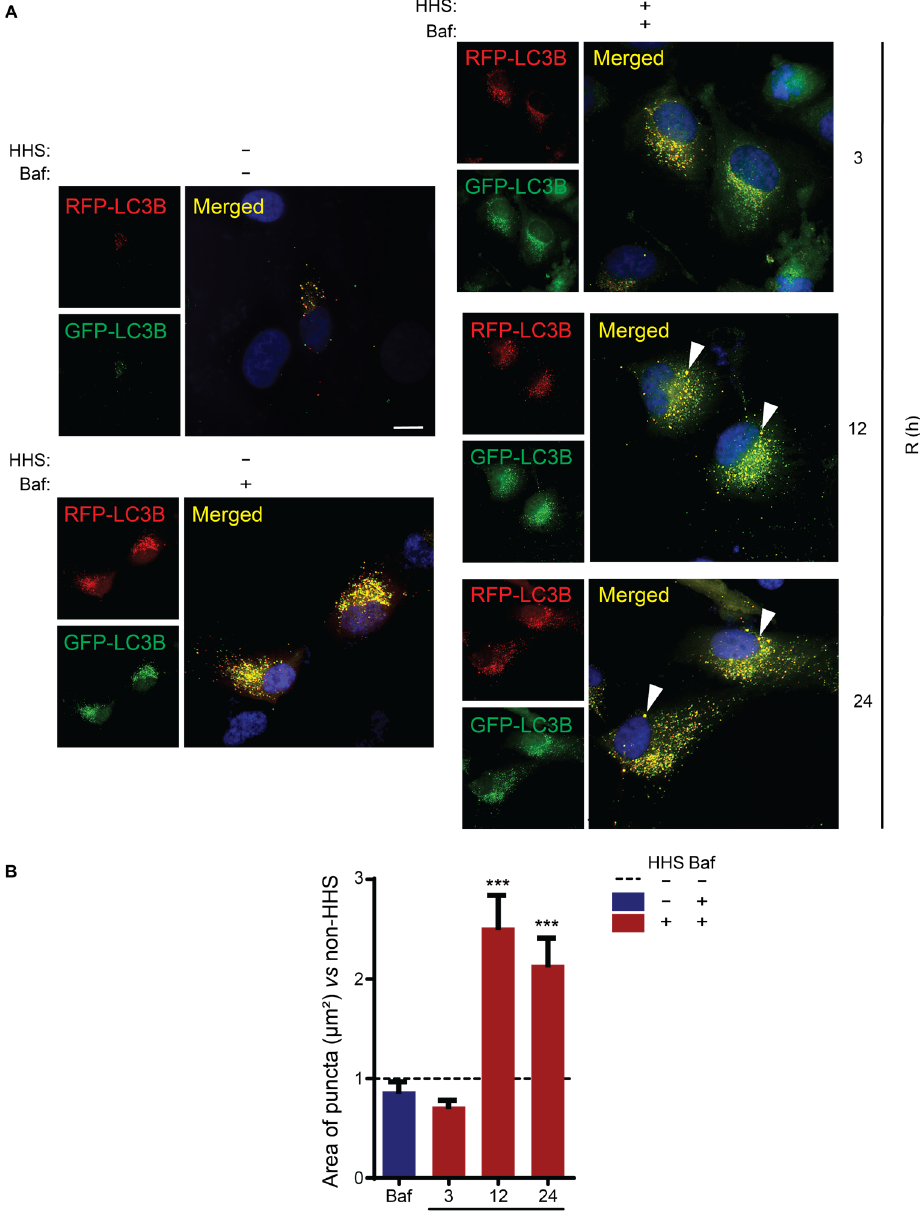
Figure 6. Hormetic heat shock increases size of autophagosome. ARPE-19 cells were transfected with RFP-GFP- LC3B construct for 16 h; then, were exposed initially for 6 h to 50 nM Bafilomycin (Baf). Later, the cells were treated without HHS (–) or with 30 min HHS (+) at 42 °C, followed by recovery at 37 °C in the presence of Baf. Non-HHS/Non-Baf were used as a control. ( A ) Immunofluorescence analysis was illustrated for autophagosome puncta (yellow) and autolysosome (red). Nuclei was counterstained with Hoechst (blue), and the arrowhead points to autophagosomes. ( B ) The area of yellow puncta (scored autophagosome’s size) was analyzed per sample and quantitative analysis was normalized to Non-HHS/Non-Baf, represented as a dashed line (---). R shows the post-HHS time of recovery at 37 °C. Statistical analyses are shown as mean ± SEM ( n = 60) followed by one-way ANOVA by Sidak test (*** p < 0.001 vs. C). Scale bar = 20 μ m.